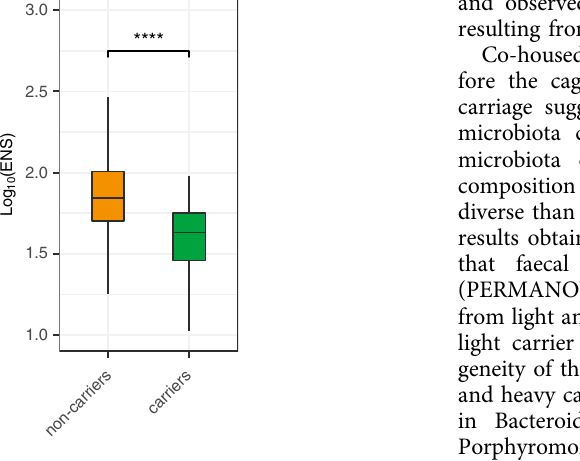
Fig. 4 Lm faecal carriage correlates with low α -diversity in humans. α - diversity, measured by ENS between carriers and non-carriers ( n carriers = 108, n noncarriers = 2130, P < 10 − 15 ). Statistical comparison was performed with a two-sided Wilcoxon rank-sum test. For boxplots, the hinges represent the fi rst and third quartile of the distribution. The whiskers extend from the hinge to the largest or smallest value no further than 1.5 x IQR from the respective hinge (where IQR is the inter-quartile range or distance between the fi rst and third quartiles). Points beyond this limit are